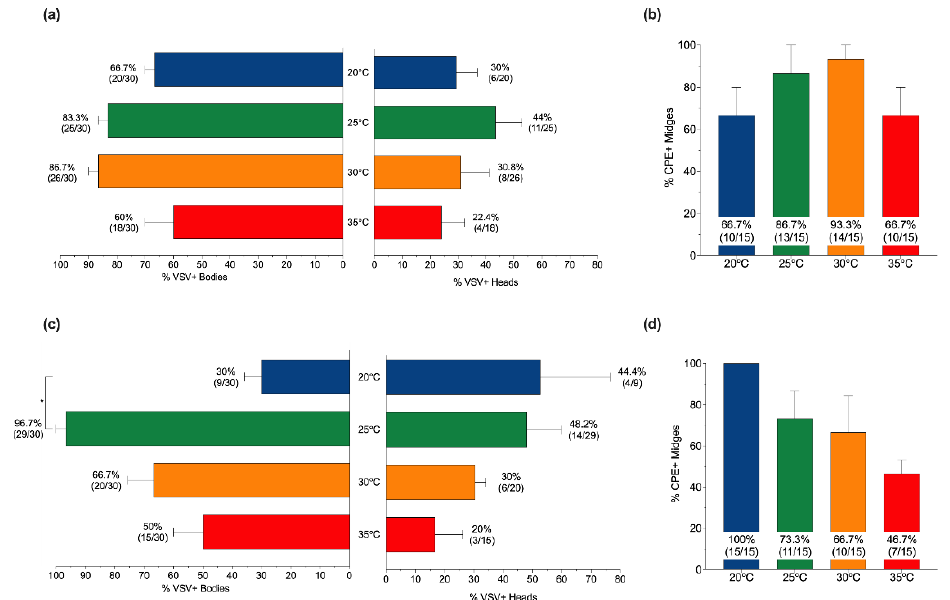
Figure 4. Constant temperature-mediated effects on infection rates of Culicoides midges orally infected and provided ( a , b ) a second (2BM) and ( c , d ) a third (3BM) blood meal while being held at constant temperatures of 20 °C (blue), 25 °C (green), 30 °C (orange), and 35 °C (red). ( a , c ) Infection rates of bodies and heads as detected by RT-qPCR and ( b , d ) infectious virus in whole bodies as detected by cytopathic effect (CPE) screening after one or two passages on Vero cells. The Kruskal–Wallis test with multiple comparisons was used to determine statistical significance (* p ≤ 0.05). Error bars represent the standard error of the mean (SEM).